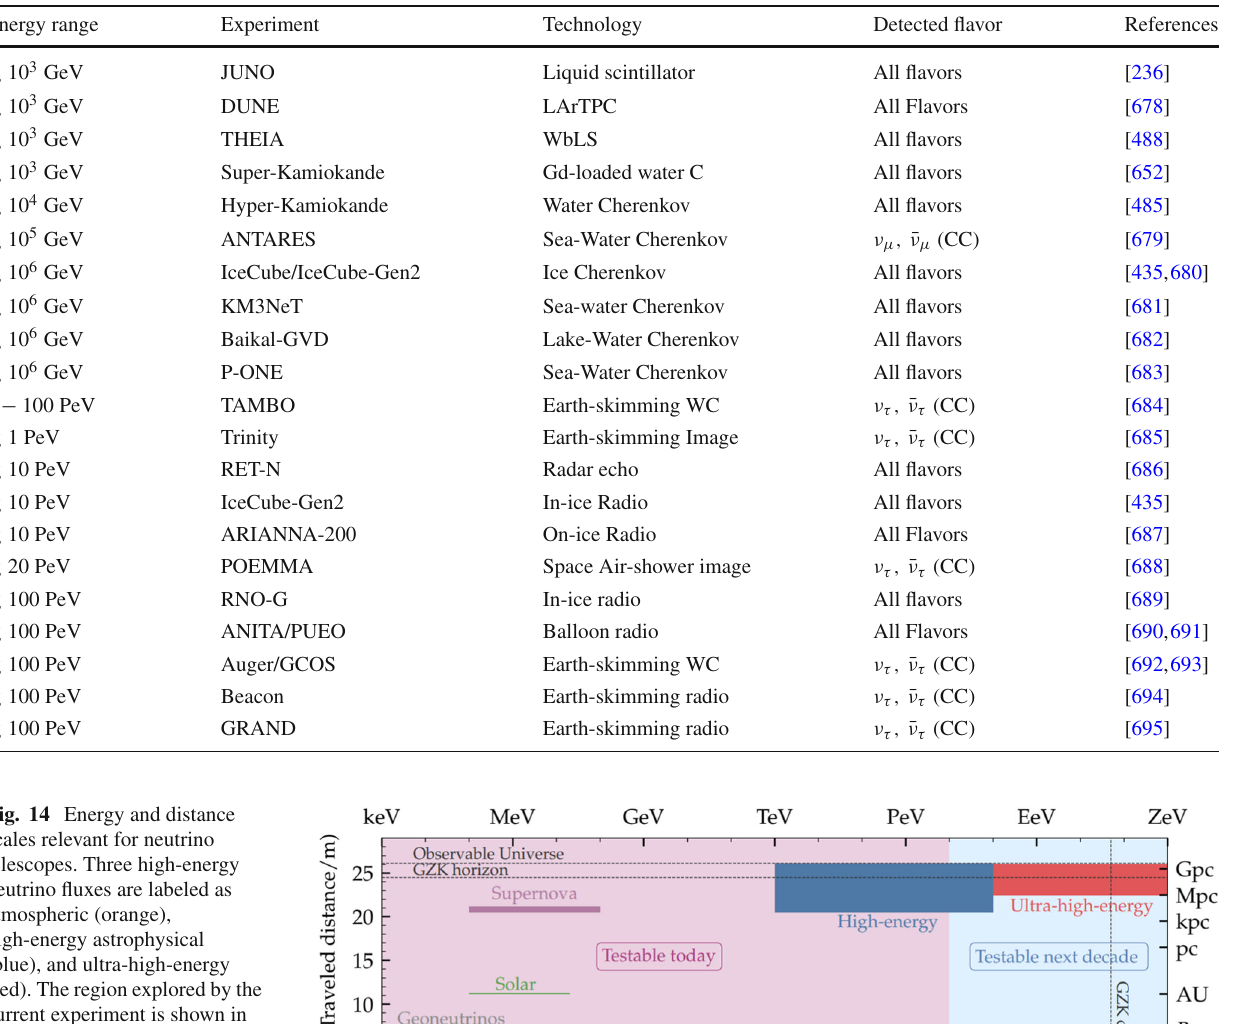
telescopes (EHENT, bottom). The detector technology and the neutrino interactionthat they are sensitive to are shown in the right most columns with references. The label ‘All Flavors’ implies that they can also detect both charge- and neutral-current interactions. Table adapted from [696]